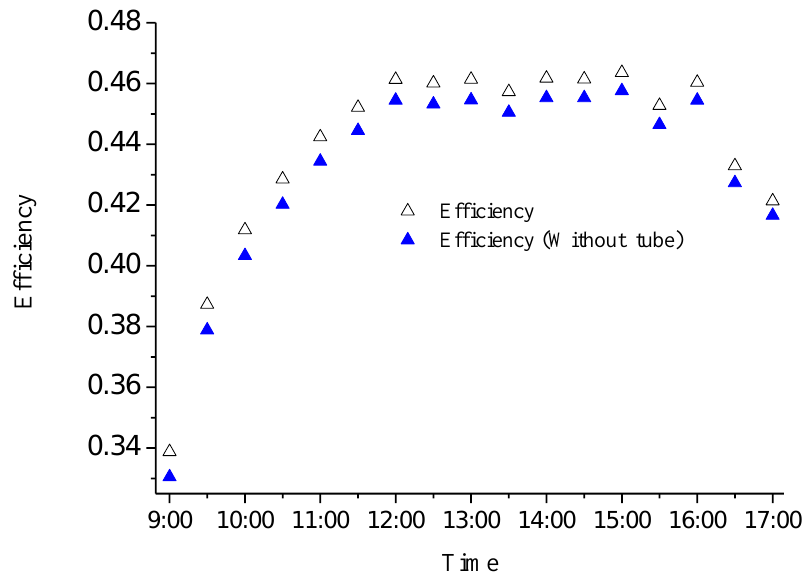
Figure 14. Efficiency of DFSC and solar radiation.